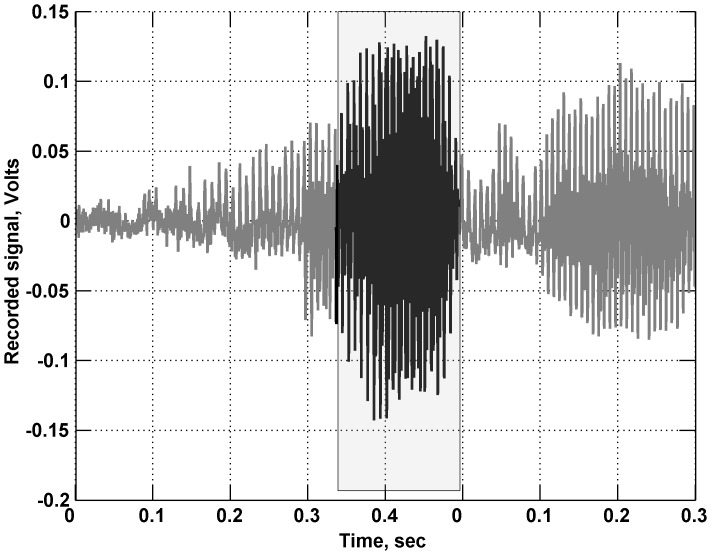
Example issue with simple energy detector.The threshold may miss the start of the acoustic event and is frequently crossed during speech events (shown above), increasing the chance of misclassification.